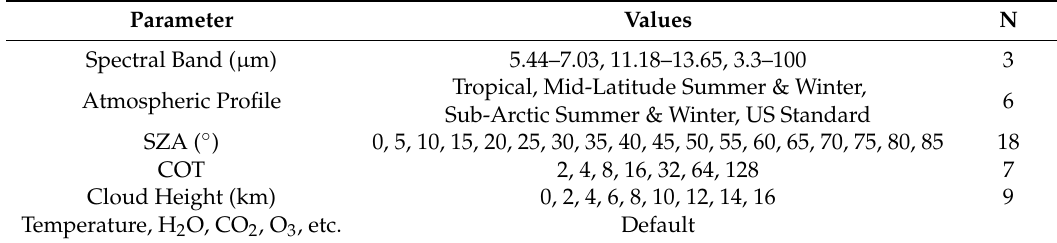
Table 5. Regression coefficients of each channel for converting radiance into irradiance Channel k 0